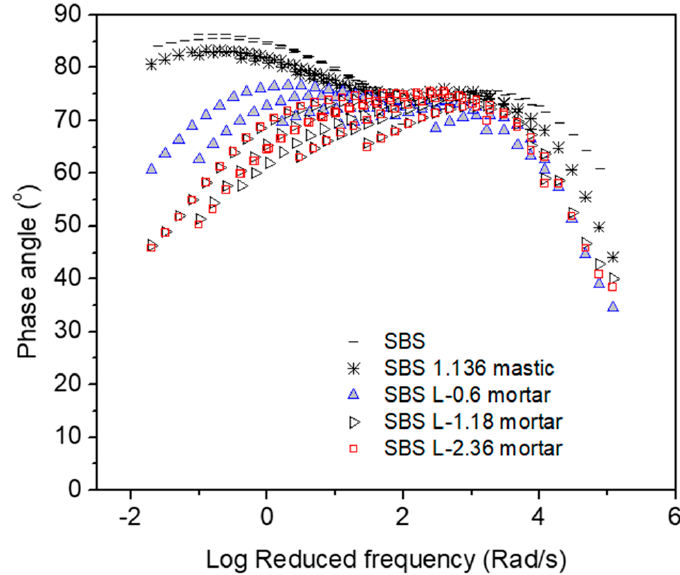
Figure 4. Phase angle master curves of AC ‐ 20 based asphaltic materials including neat asphalt binder, mastic and mortar at a reference temperature of 60 °C.